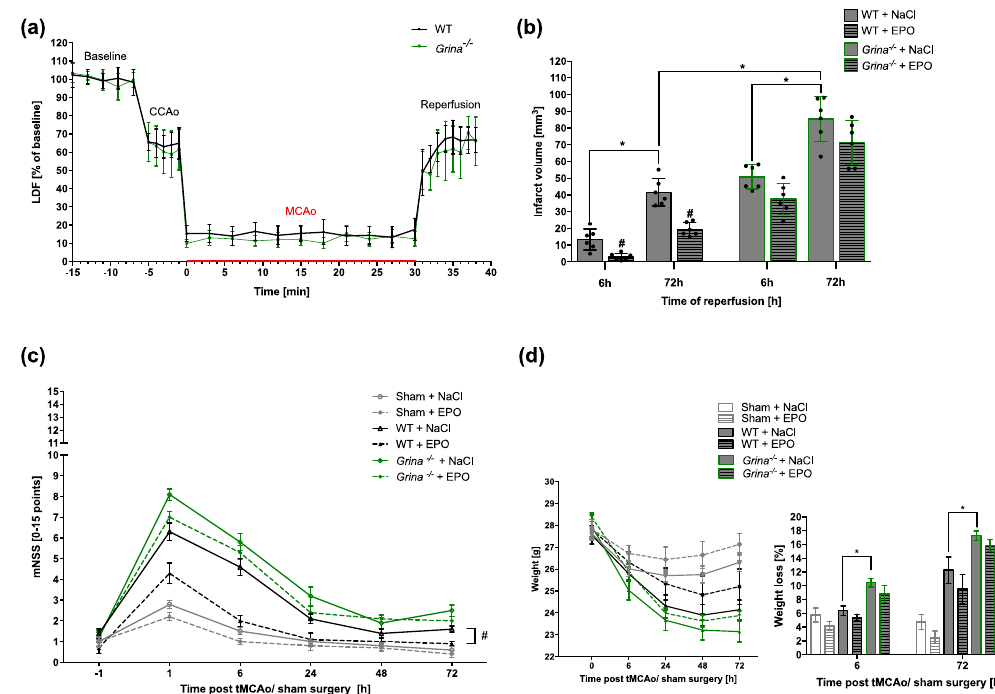
Figure 2. GRINA deficiency increases infarct sizes and worsens clinical outcome after murine cerebral ischemia ( a ) Ipsilateral laser doppler flowmetry was used to monitor blood perfusion after the occlusion of CCA, MCA and the early reperfusion phase. The baseline blood flow was considered as 100% for both genotypes. 80% reduction of blood flow was defined as su ffi cient MCAo ( n = 10). Abbreviations. CCAo: Common Carotid Artery occlusion; MCAo: Middle Cerebral Artery occlusion; LDF: Laser Doppler flowmetry. ( b ) Infarct sizes of Grina − / − mice and wildtype littermates after 30 min of tMCAo followed by 6 and 72 h of reperfusion and EPO (5000 U / Kg) or saline (Vehicle) treatment were quantified ( n = 6). ( c ) Modified neurologic severity score (mNSS) in a time-dependent manner ( − 1 h to 72 h) was assessed to grade neurological outcome after stroke. Sham ( n = 8), wildtype littermates, ( n = 10) Grina − / − ( n = 10) mice. ( d ) Weight of all groups during the observation period and percent of losed weight at 6 and 72 h of reperfusion after stroke / sham surgery is shown in sham ( n = 8), wildtype littermates ( n = 10) and Grina − / − ( n = 10) mice. Bars represent means ± SD. * p < 0.05 intergroup or treatment comparison, # p < 0.05 EPO treatment compared to the vehicle group.